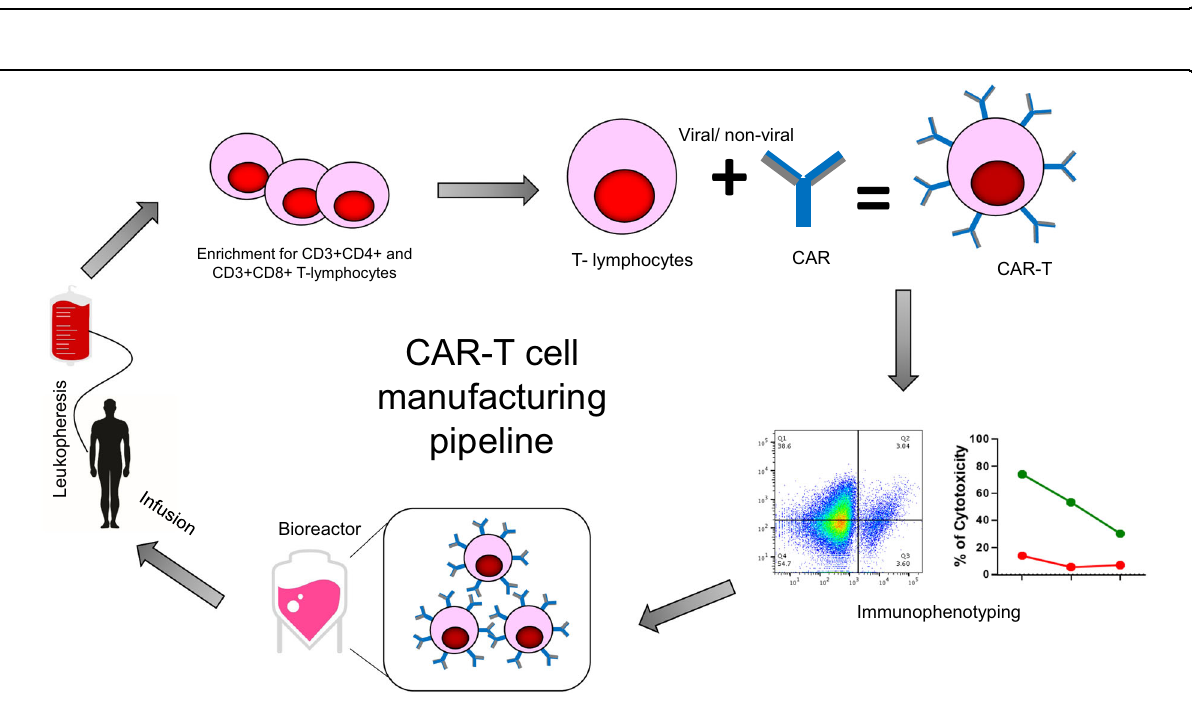
Fig. 4 CAR T-cell manufacturing pipeline. The process starts off with leukapheresis to obtain PBMCs from the patients. Enrichment of T cells is done prior to genetic modi fi cations via viral or non-viral gene delivery system. This is followed by immunophenotyping analysis to determine the cytokine and cytolytic pro fi le of the CAR T cells. Positive CAR T cells are selected to undergo ex vivo expansion in a bioreactor vessel containing growth factor-enriched media. When the required amount is obtained, the CAR T cells will be transported back to the clinic for patient infusion.